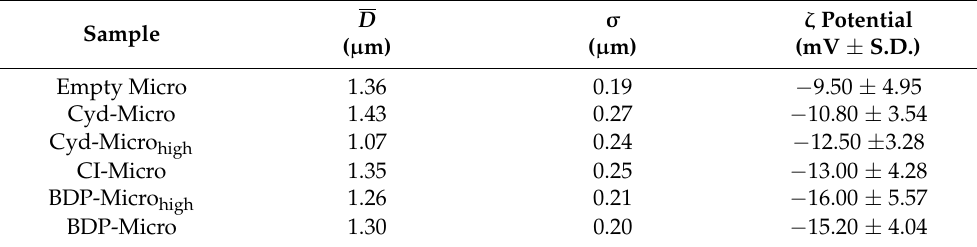
Figure 2. SEM images of Empty Micro, CI-Micro CI-Micro, BDP-Micro high and BDP-Micro samples. Bar represents 10 µm. Table 2. Mean size ( D ) and standard deviation ( σ ) of MP samples, determined by ImageJ software (Version 1.53t).